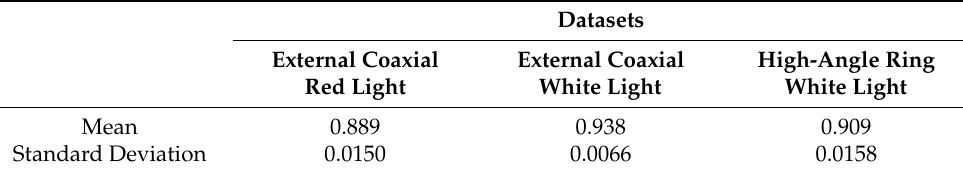
Table 4. Accuracy of the models of the first task using the datasets of images illuminated by three different light